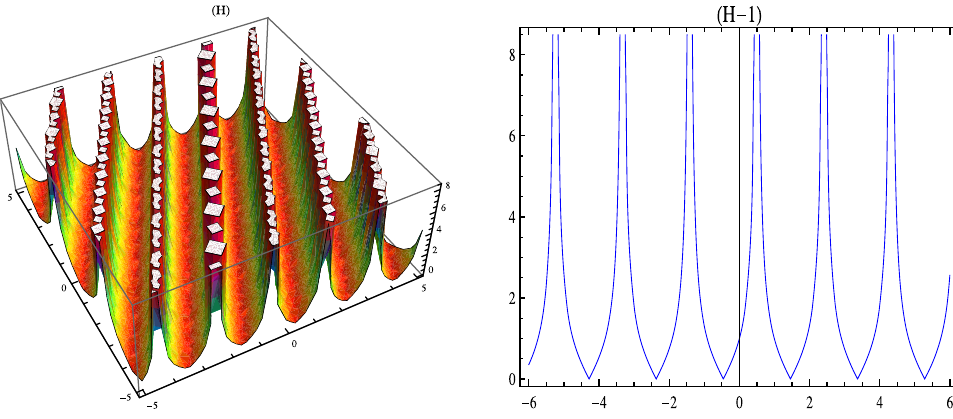
Figure 8: ( H ) 3D graph of ( 83 ) with a 2.25